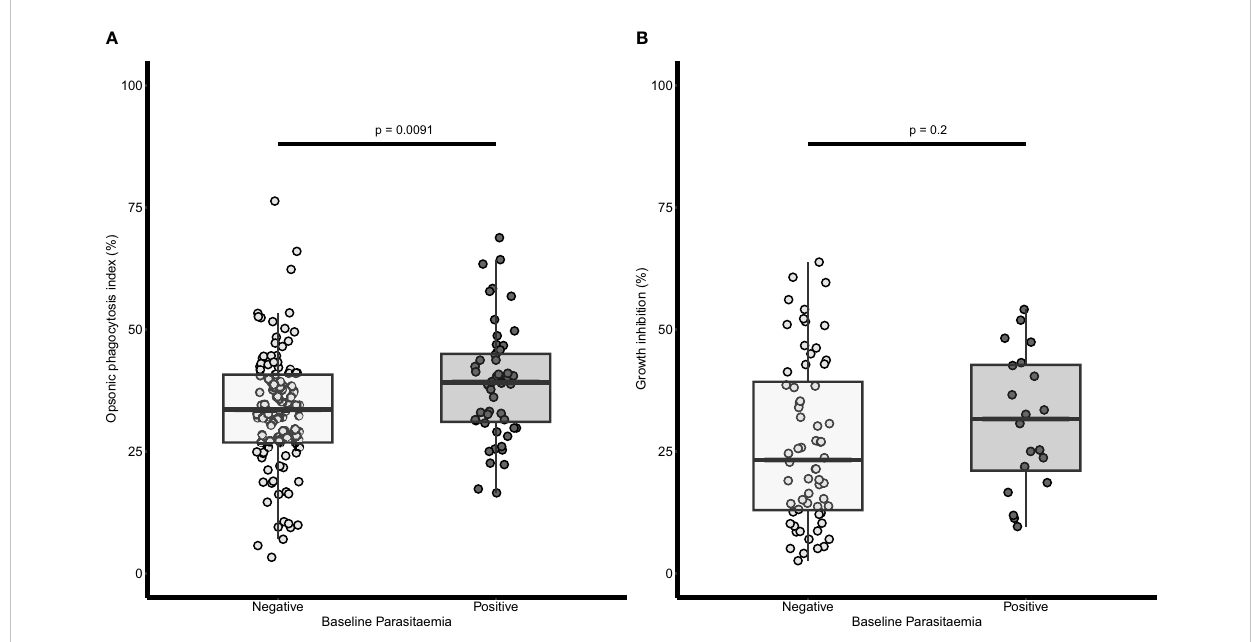
FIGURE 1 Relationship between baseline parasitaemia and opsonic phagocytosis (OP) and growth inhibition respectively. (A) A dot plot of OP and baseline parasitaemia (n=238). (B) A dot plot of growth inhibition activity and baseline parasitaemia (n=84). Parasitaemia was de fi ned as any parasite count by microscopy examination of blood slides. The lighter dots and boxes are for children without baseline parasitaemia and the darker dots and boxes are for those with baseline parasitaemia. The horizontal lines within the boxes are the median of the distribution, the upper and lower borders of the box denote the upper and lower quartiles respectively. The upper and the lower whiskers indicate the maximum and minimum OP values respectively. P values were derived from the Mann Whitney U test.